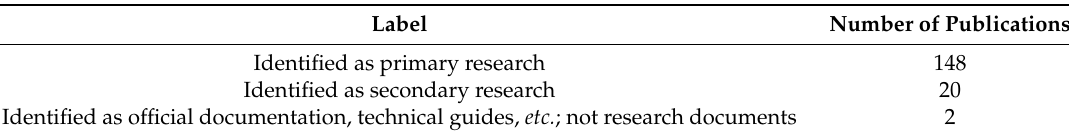
Table 6. Frequency ranking of research